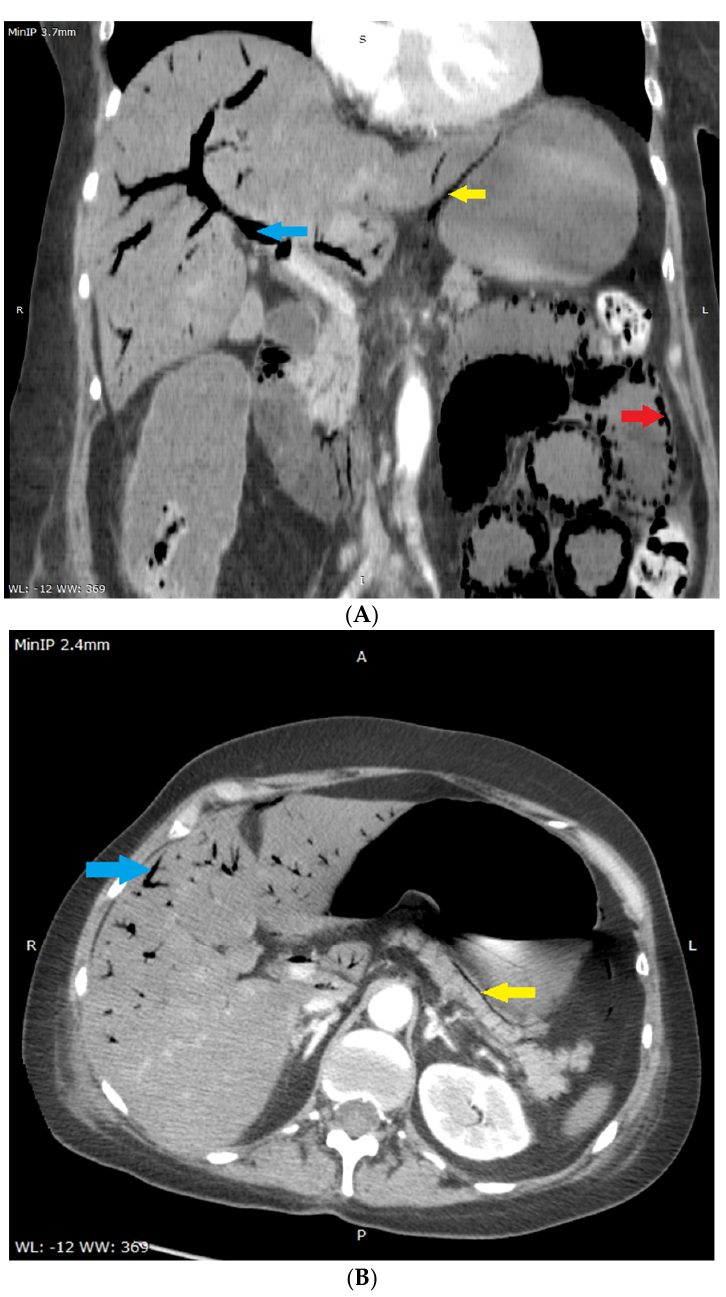
Figure 2. ( A , B ) Multi-phase abdominal computed tomography performed immediately after liver US. No oral contrast was administered due to urgency–the stomach is filled with accidental content